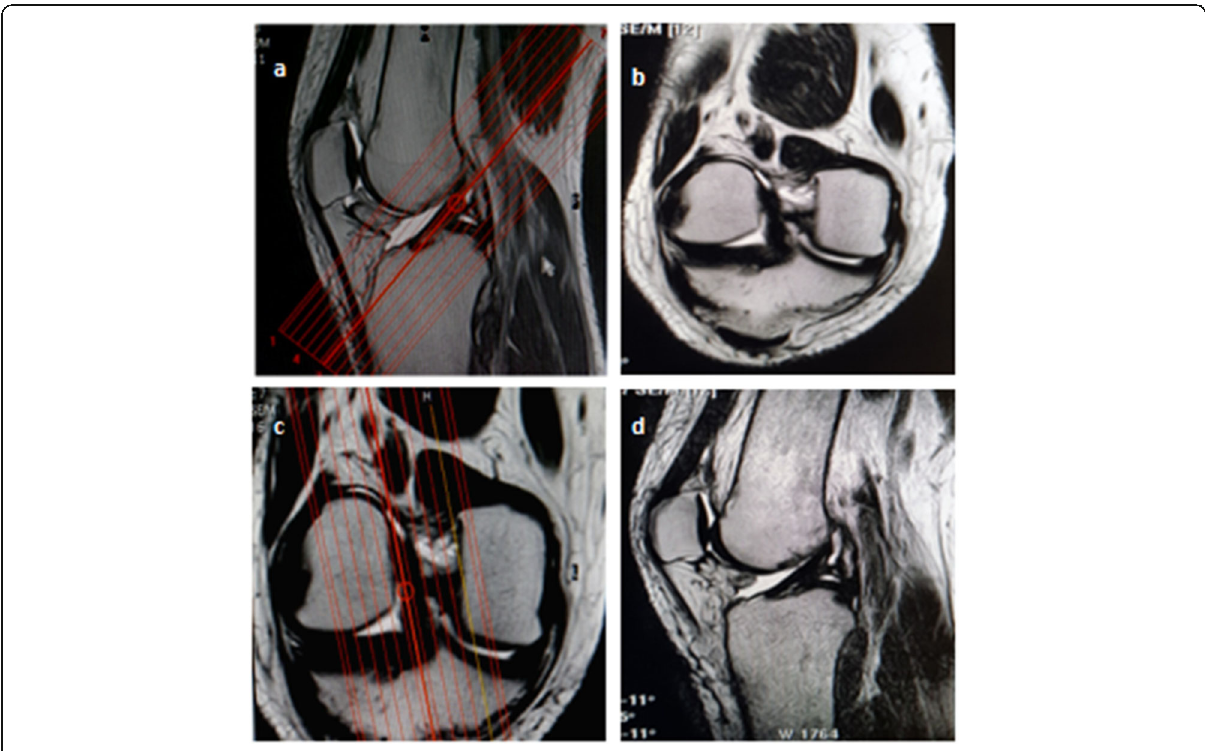
Fig. 1 A technique to obtain oblique coronal and sagittal MR images of a normal ACL. a Orthogonal sagittal T2 image used to obtain b oblique coronal T2 image by superimposing 2-mm-slice thickness cuts with 0.5-mm interval on it in a plane parallel to the femoral intercondylar roof along the course of the ACL. c Topogram of oblique coronal T2 image used to obtain d oblique sagittal T2 image by superimposing 2-mm-slice thickness cuts with 0.5-mm interval on the former in a plane parallel to the medial border of the lateral femoral